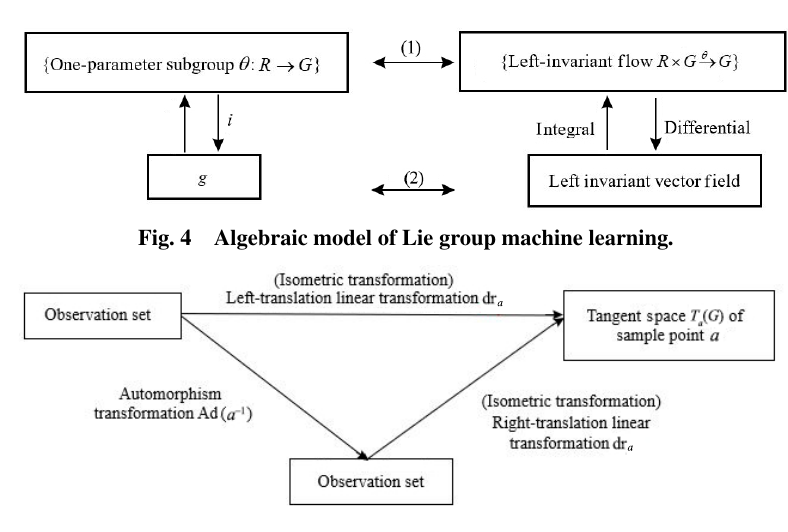
Fig. 5 Geometric model of Lie group machine